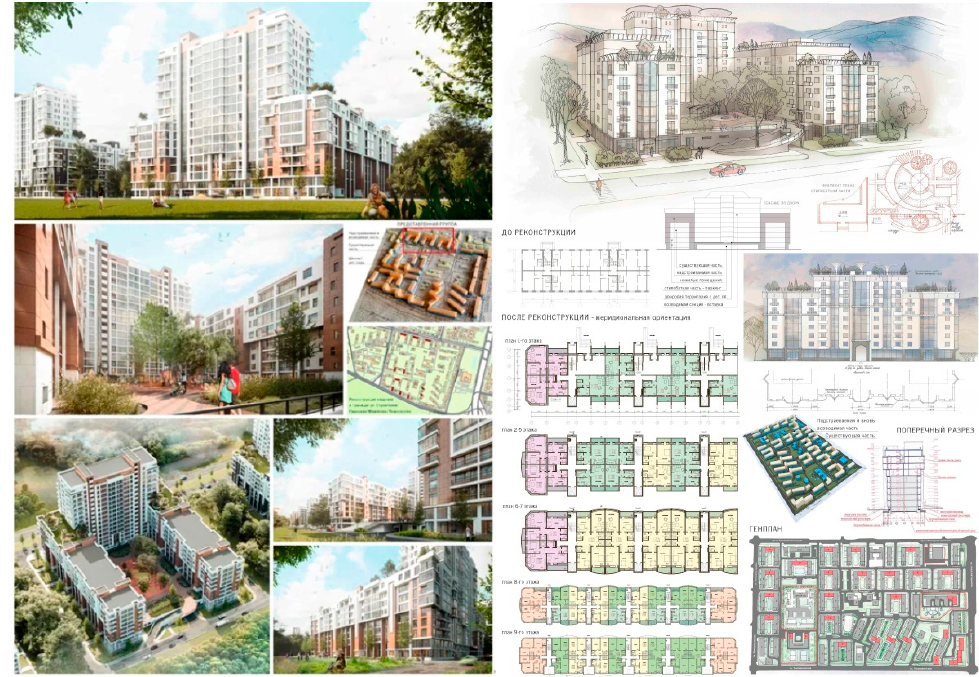
Figure 17. Reconstruction of mass residential development (projects of A.V. Krotov’s workshop) https://www.akrotov.ru (accessed on 15 January 2022).